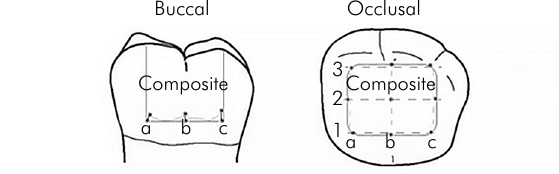
Figure 2. Analysis of gaps at the resin/tooth interface. *Point of gap measurement by